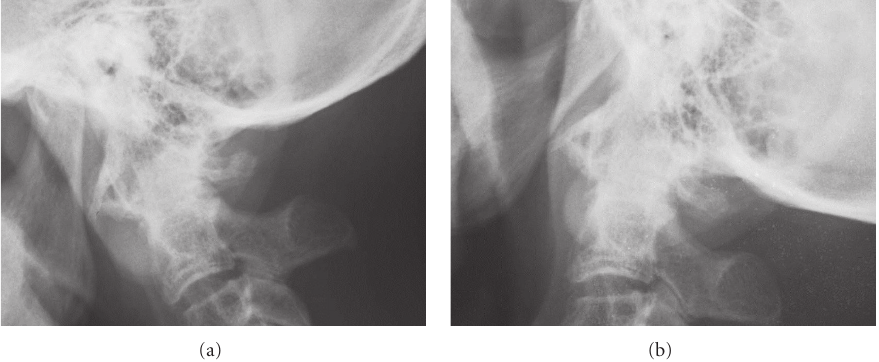
Figure 4: Postoperative dynamic lateral plain radiographs. Flexion (a) and extension (b) view. Atlantoaxial subluxation had not